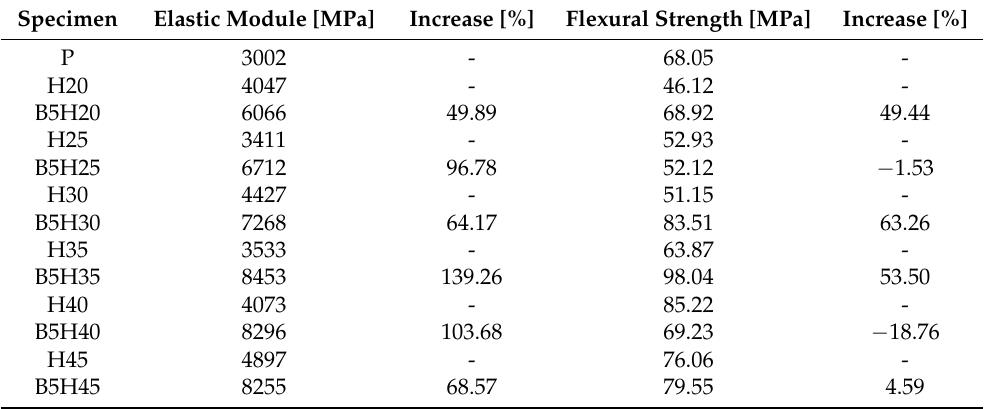
Table 6. Summary of the results of the flexural